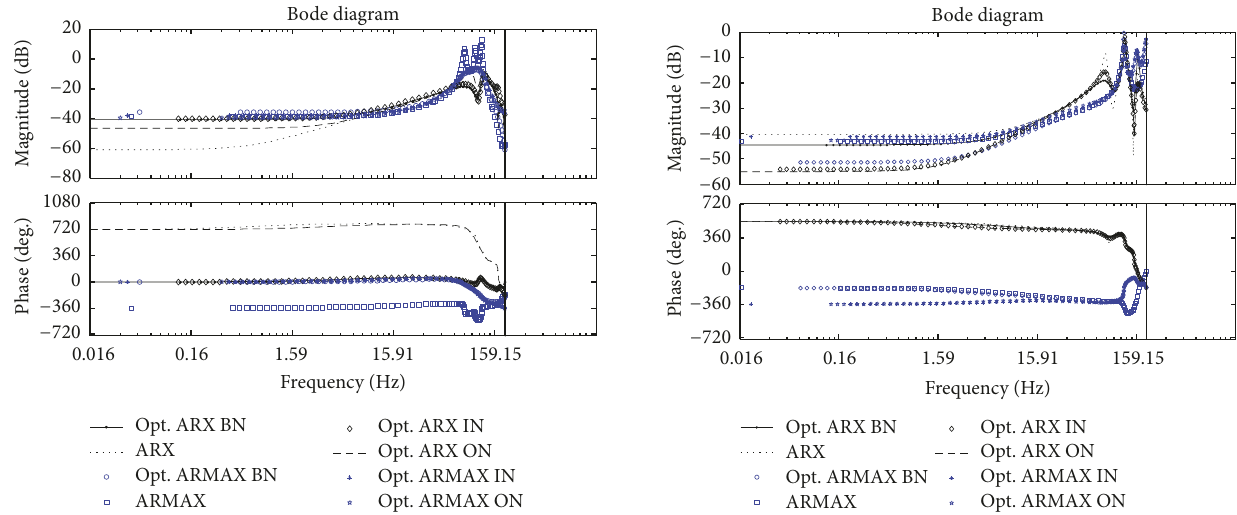
Figure7:BodeplotforARX(black)andARMAX(blue)realization; flow coefficient = 0.58. Data is filtered and resampled prior to system identification.